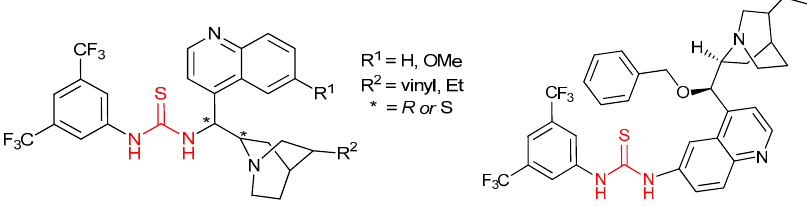
Figure 15. Thioureas derived from Cinchona alkaloids [216,217,250].